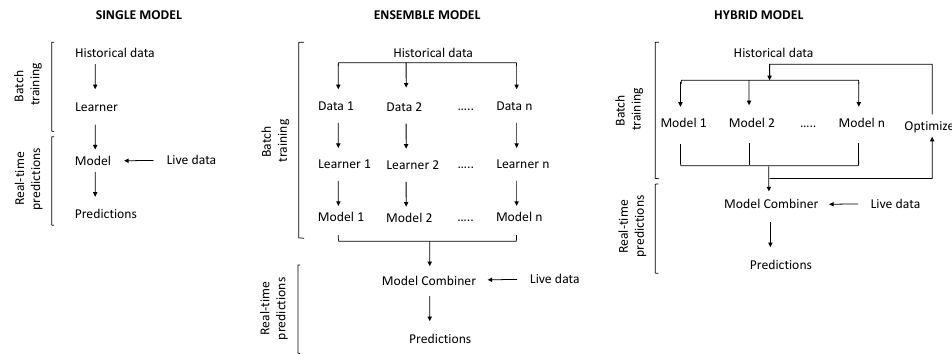
Figure 1. Overall structure of single, ensemble, and hybrid models. Adapted from [1].